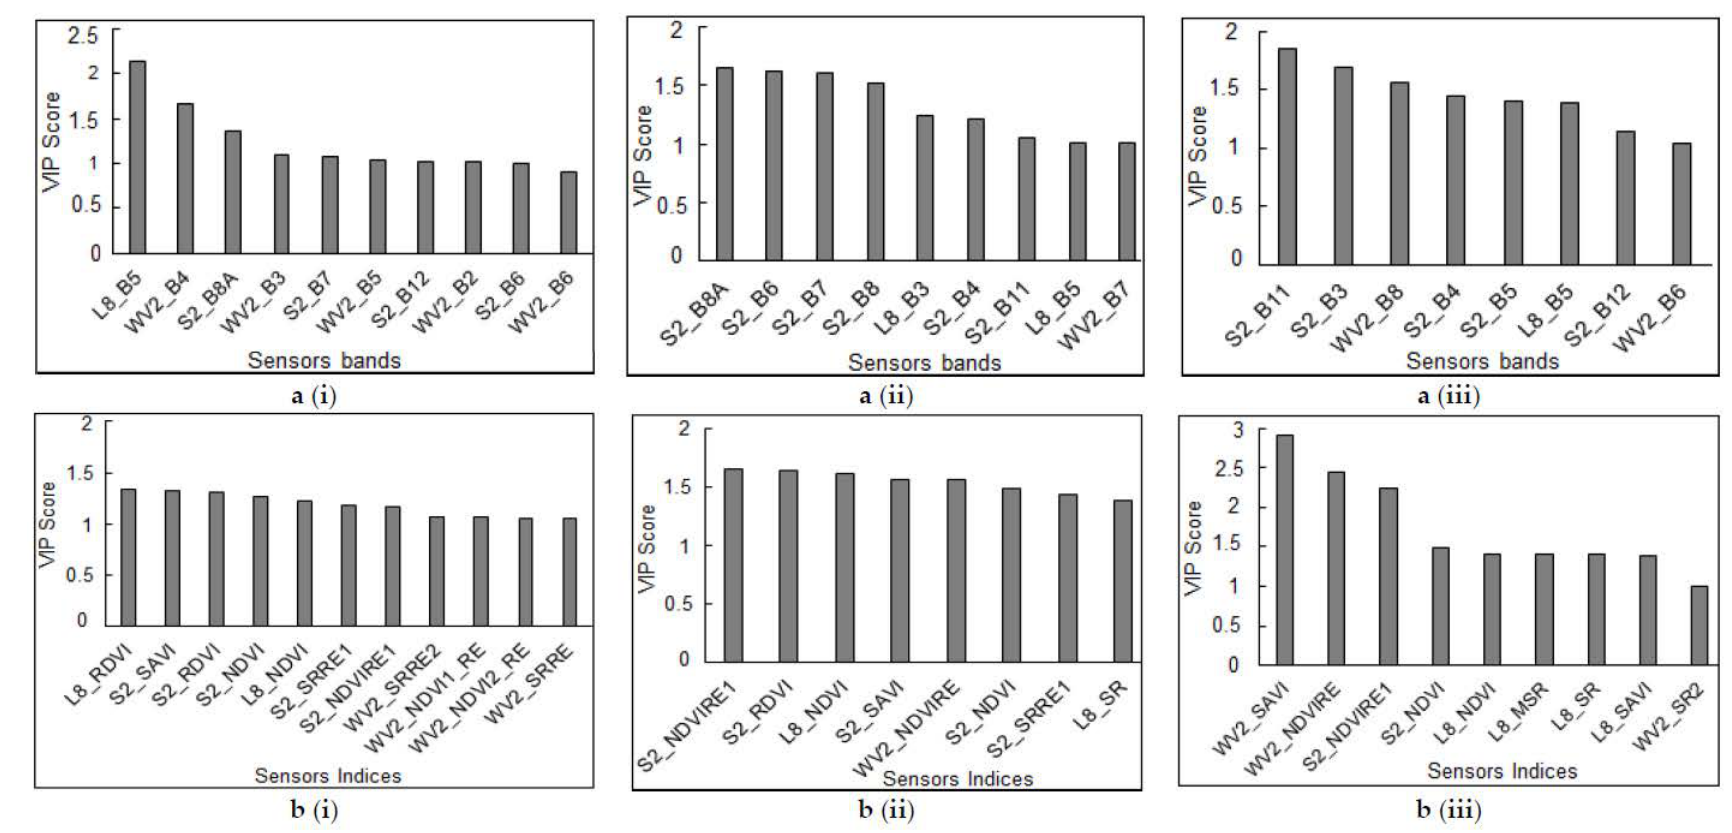
Figure 5. The most important ( a ) bands and ( b ) indices for estimating ( i ) F. costata , ( ii ) T. triandra , and ( iii ) combined species AGB across